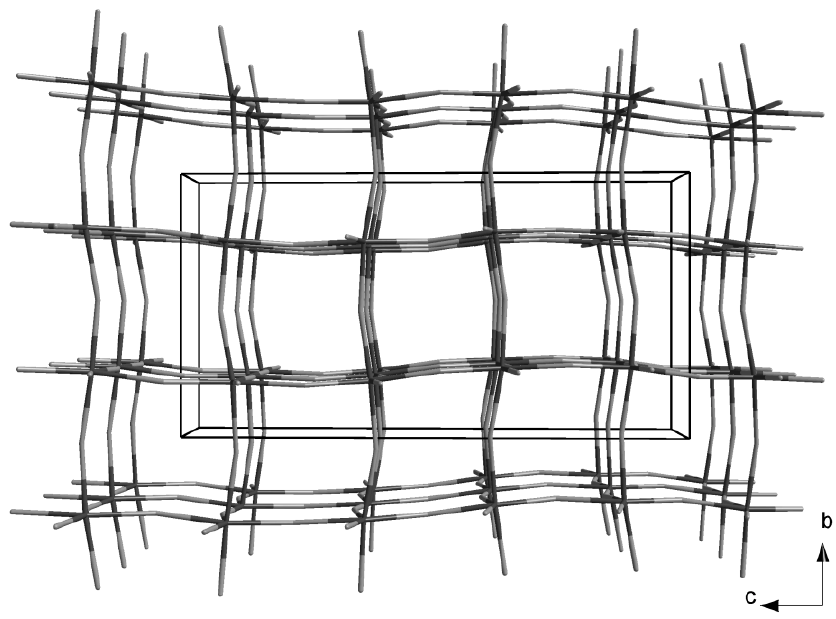
Figure 5. Schematic presentation of the 3D network with distorted cubic topology in 11 (along the 100 direction). Reproduced with permission from ref. [44]. © 2022 American Chemical Society.